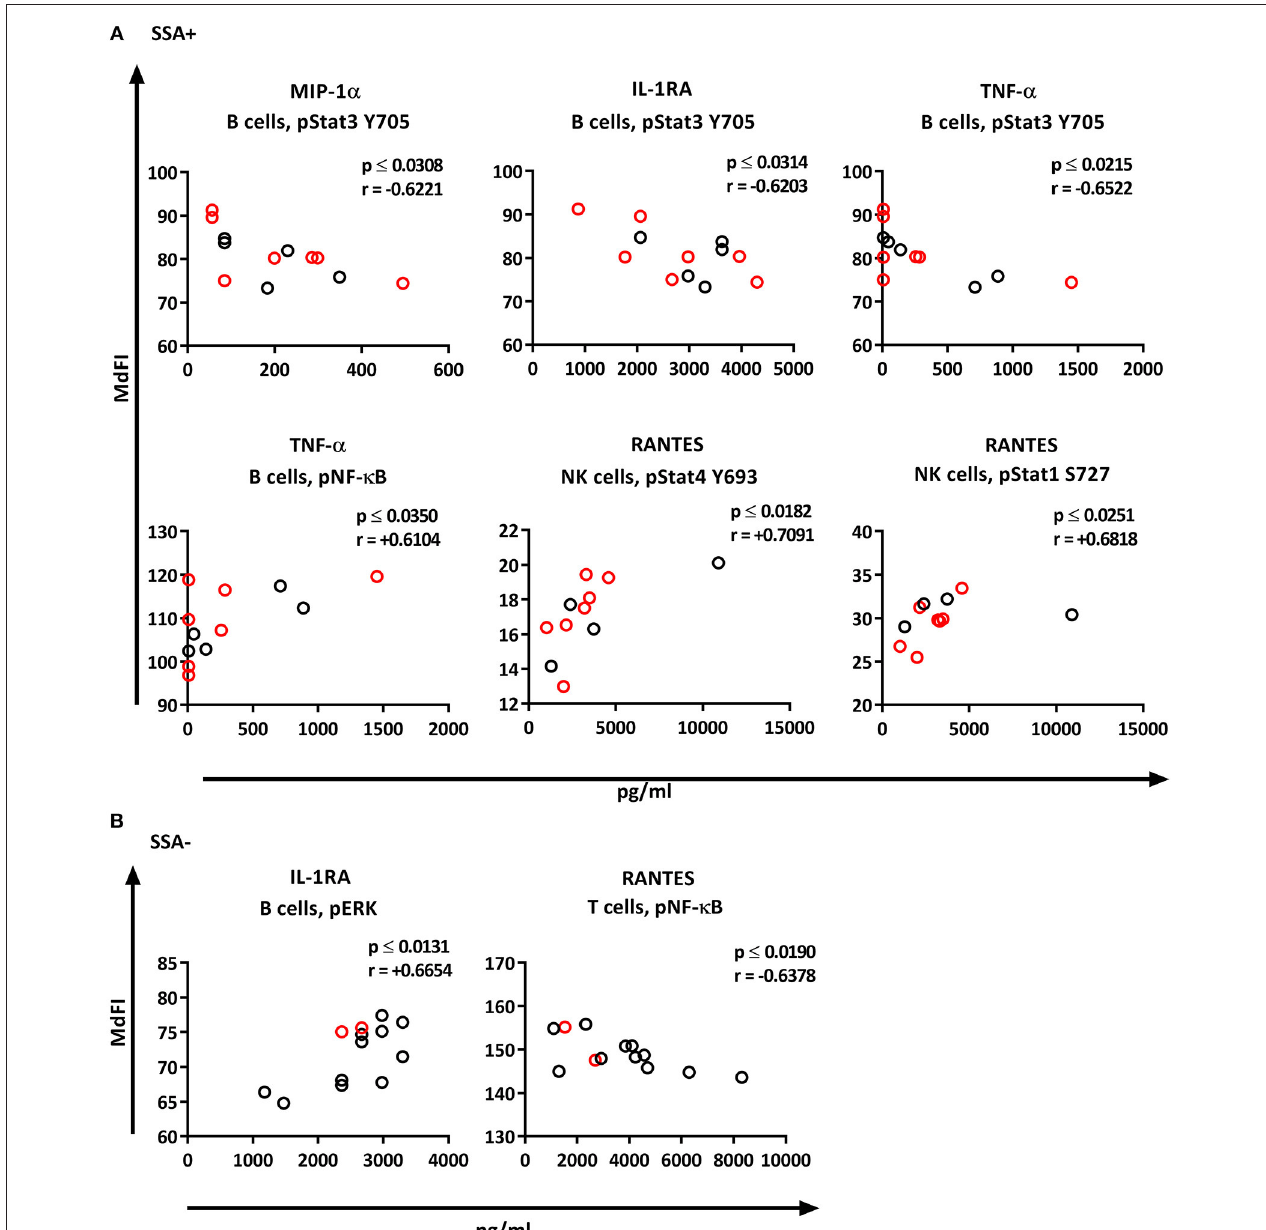
FIGURE 8 | Correlation of basal phosphorylation status with plasma cytokine levels in pSS patients grouped according to autoantibody status. Autoantibody positive pSS patients (SSA + ) (A) , autoantibody negative pSS patients (SSA–) (B) . Correlations were assessed by Spearman’s rank test. Medicated patients are shown in red while un-medicated patients are shown in black. Strong ( r = 0.6–0.79) to very strong ( r = 0.8–1.0) associations are shown with respective p and r -values given at the side of each graph. Associations were considered statistically significant for p ≤ 0.05. X-axis denotes concentration of cytokines (pg/ml) and Y-axis denotes phosphorylation levels (MdFI). The data represents pSS patients ( n = 25) grouped into SSA + patients ( n = 12) (except for RANTES, n = 11) and SSA– patients ( n = 13).